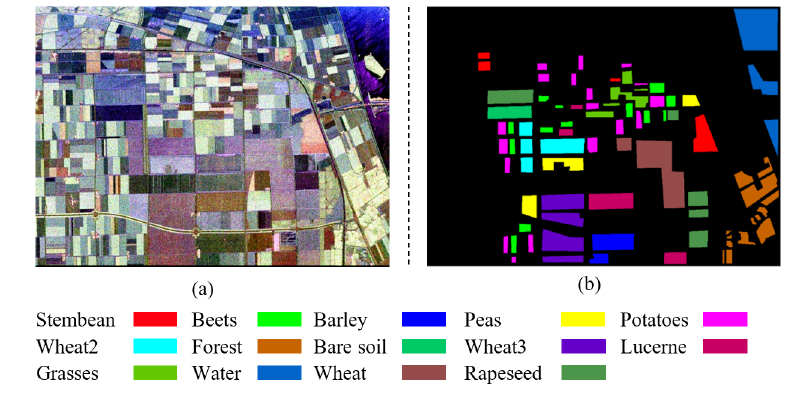
Figure 4. ( a ) Pauli RGB image of Flevoland PolSAR data; ( b ) Ground-truth image of Flevoland.